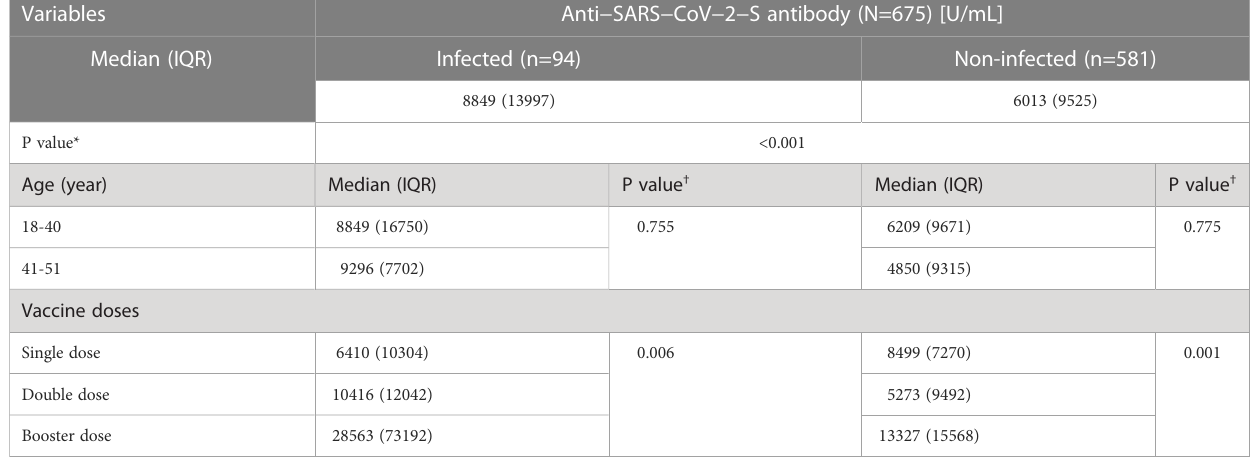
TABLE 2 COVID-19 post vaccine Anti − SARS − CoV − 2 − S antibody response among the migrant workers, Bangladesh, 2021-22. Variables